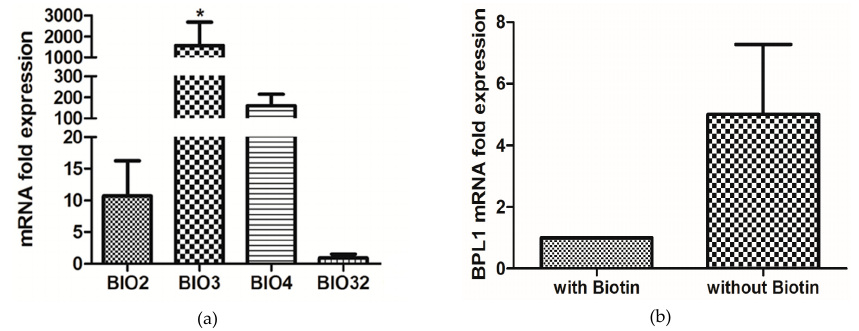
Figure 7. Relative expression of C. albicans predicted biosynthesis genes in synthetic complete (SC) medium under biotin starvation (no added biotin) relative to growth with 2 µg/L biotin (set as “1”) and normalized for the housekeeping gene CDC36 . The experiment was done in three biological replicates and displayed as the mean ± SE. Significant upregulation of genes are marked by asterisk* ( p < 0.05). ( a ) BIO2 , BIO3 , BIO4 , and BIO32 . ( b ) Biotin protein ligase, BPL1 .